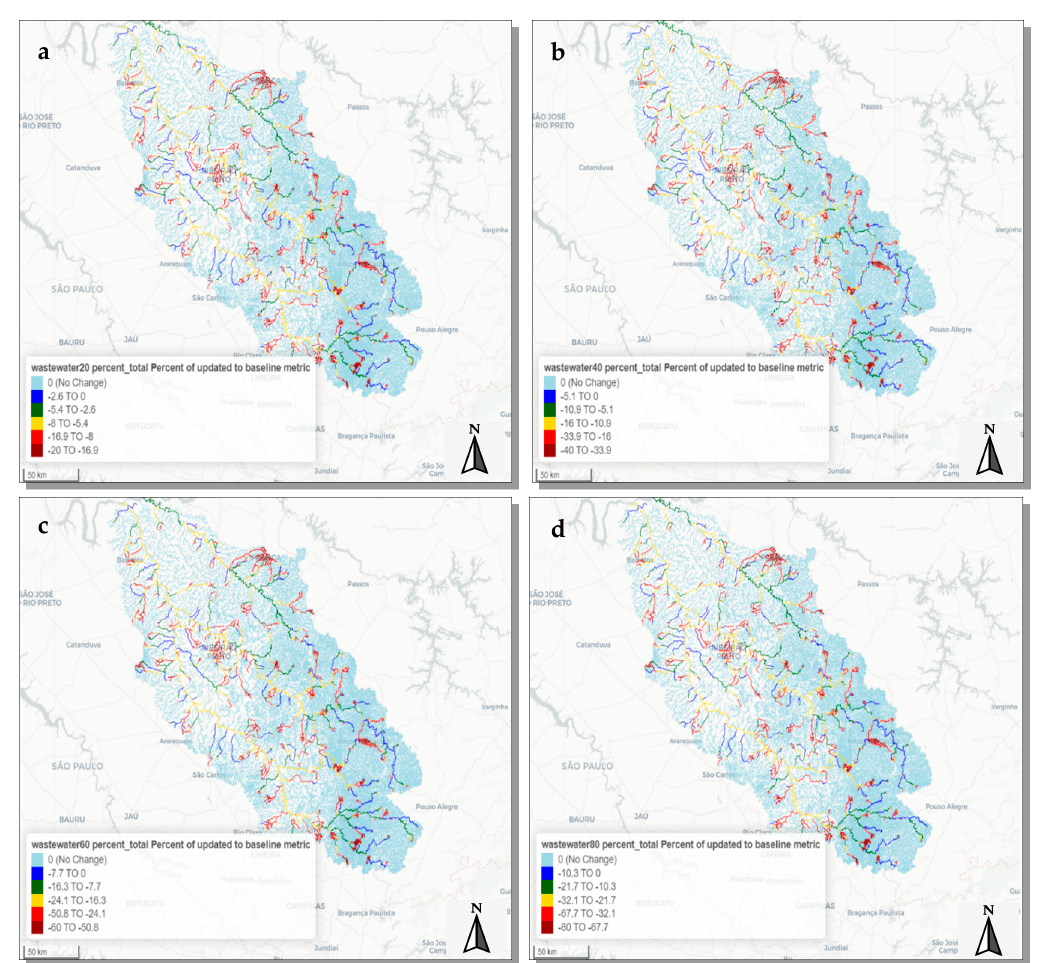
Figure 5. Map showing the predicted percent reduction in TN load in response to hypothetical reductions in TN loading per unit area from the diffuse urban land source of ( a ) 20%, ( b ) 40%, ( c ) 60% and ( d ) 80%. The colors in the map represent different predicted reductions in TN stream load as a function of the percent change in TN loading per unit area from the di ff use urban land source. Note the di ff erences in bin ranges among the maps.